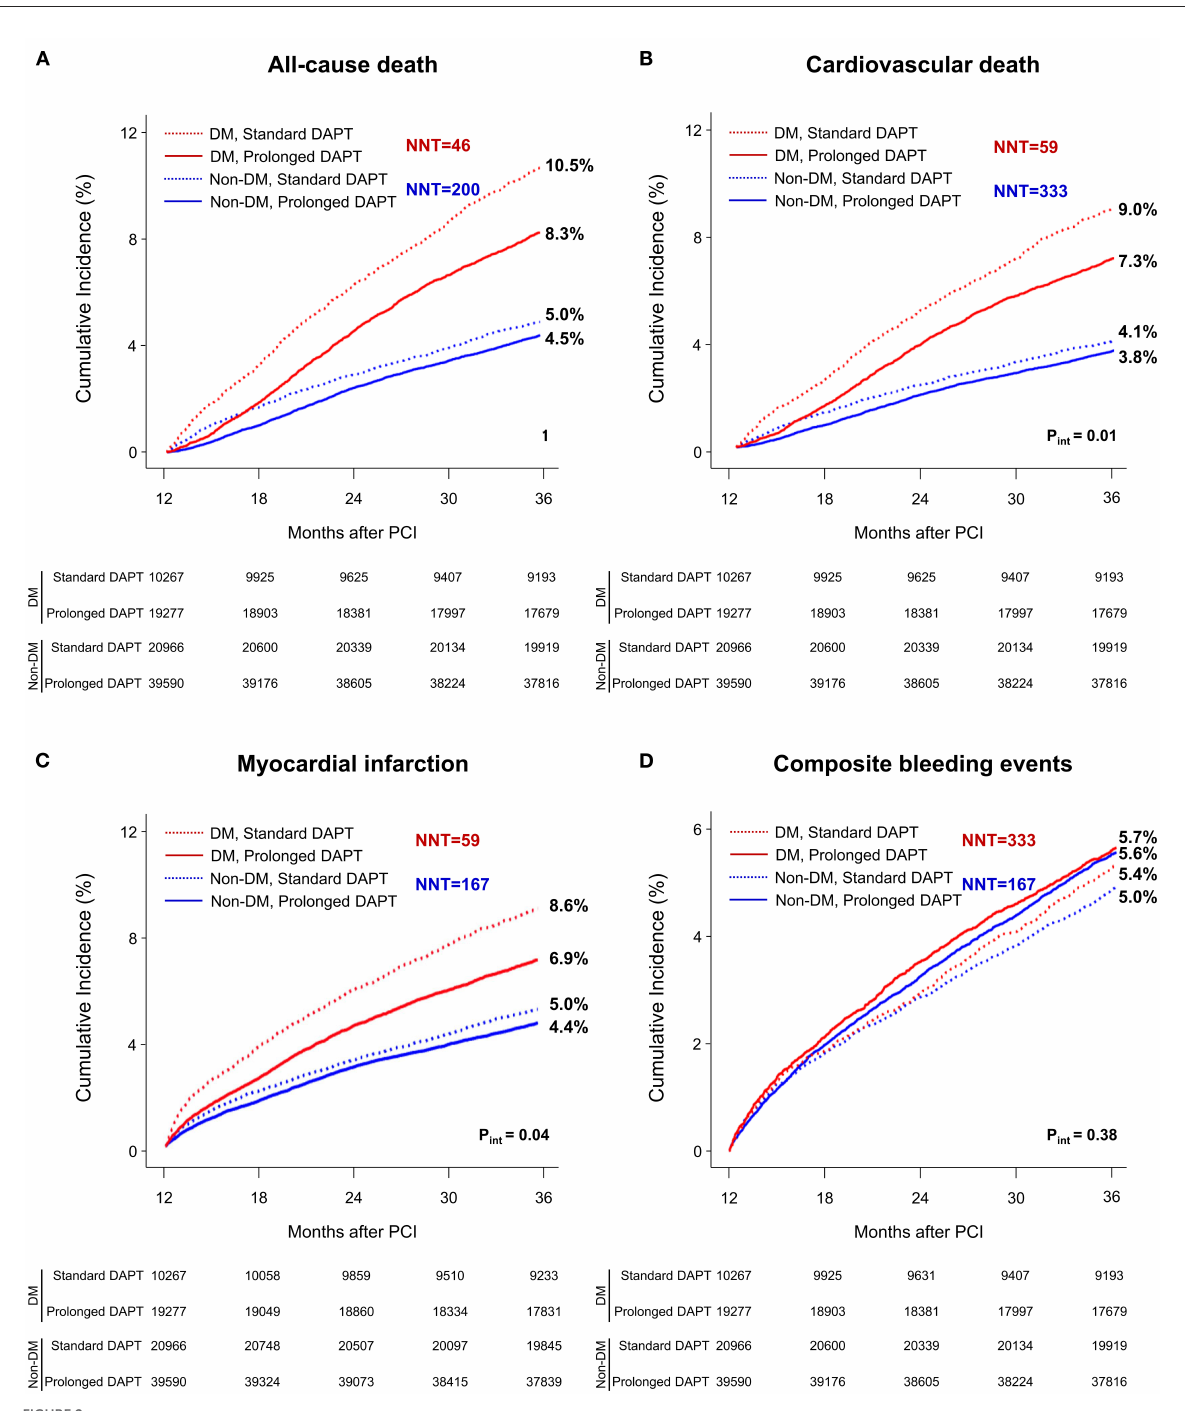
FIGURE2 Time-to-event curves for all-cause death, cardiovascular death, myocardial infarction, or composite bleeding events between 1 and 3 years after PCI. The cumulative incidence of (A) all-cause, (B) cardiovascular mortality, (C) myocardial infarction and (D) composite bleeding events between 1 and 3 years after PCI. DAPT, dual antiplatelet therapy; DM, diabetes mellitus; PCI, percutaneous coronary intervention. NNT, number need to treat; NNH, number need to